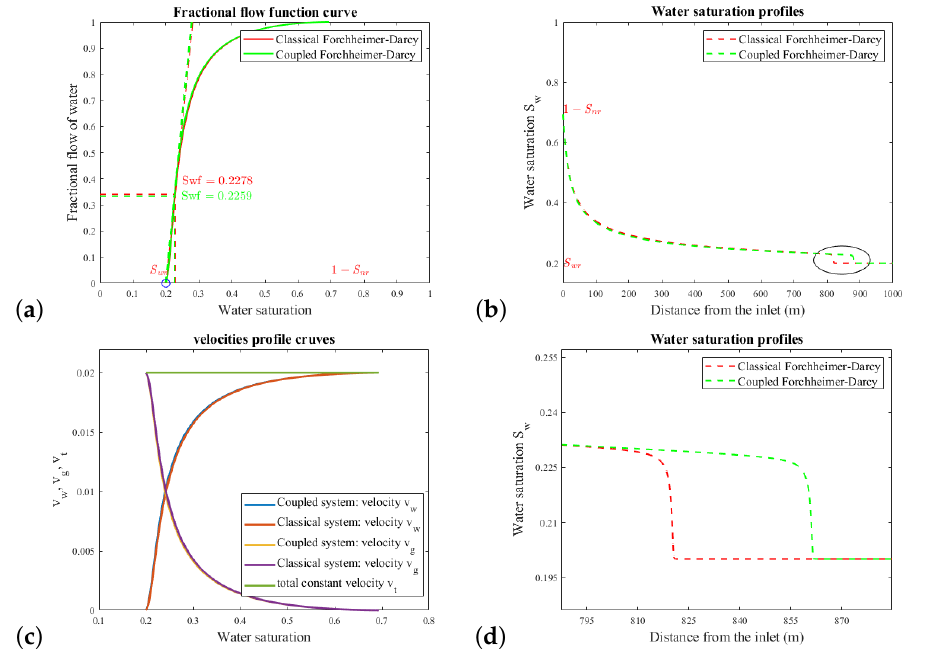
Figure 3. One-dimensional linear: ( a ) water fractional flow f w ; ( b , d ) water saturation S w at front; and ( c ) water velocity v w , gas velocity v g , the total constant velocity v t ; and water-phase pressure and gas-phase pressure after 1000 days.